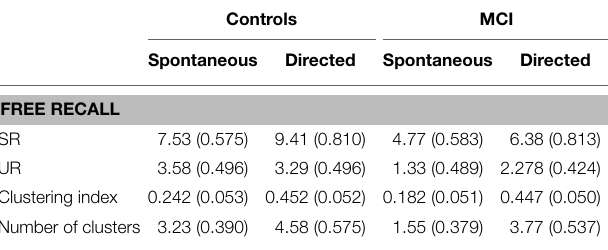
TABLE 2 | Free recall and semantic clustering performance relative to the spontaneous and the directed sessions.